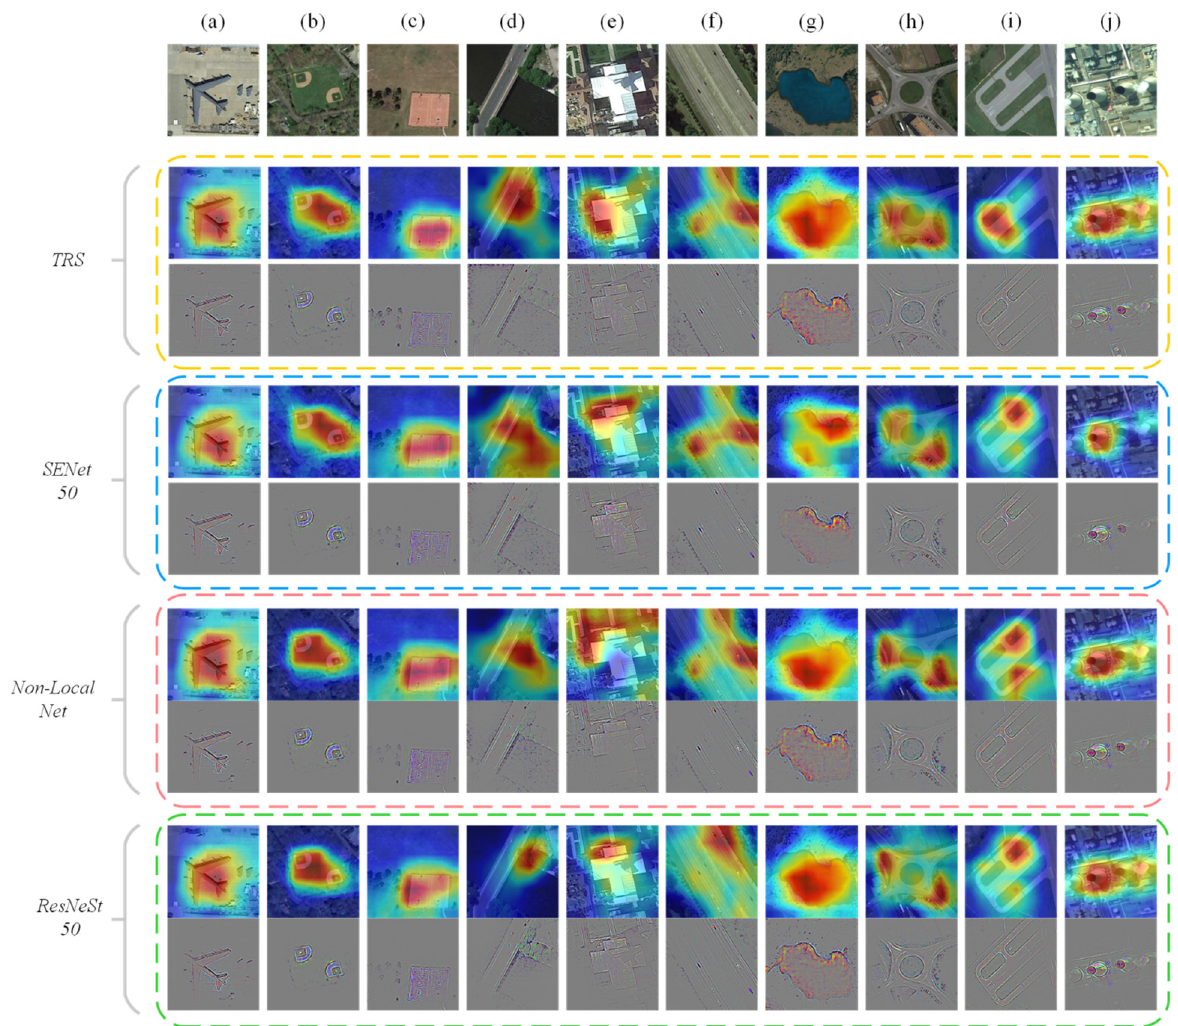
Figure 10. Visualize CAM and GB. According to the visualization results of CAM and GB, compared with SENet, Non-Local NN and ResNeSt, TRS can better focus on the important features of remote sensing scene images, especially in scenes ( a ) Airplane, ( b ) Baseball diamond, ( c ) Basketball court, ( d ) Bridge, ( e ) Church, ( f ) Freeway, ( g ) Lake, ( h ) Roundabout, ( i ) Runway, ( j ) Thermal power station. This also explains why TRS has better classification performance. Table 7. Comparison with other attention models.